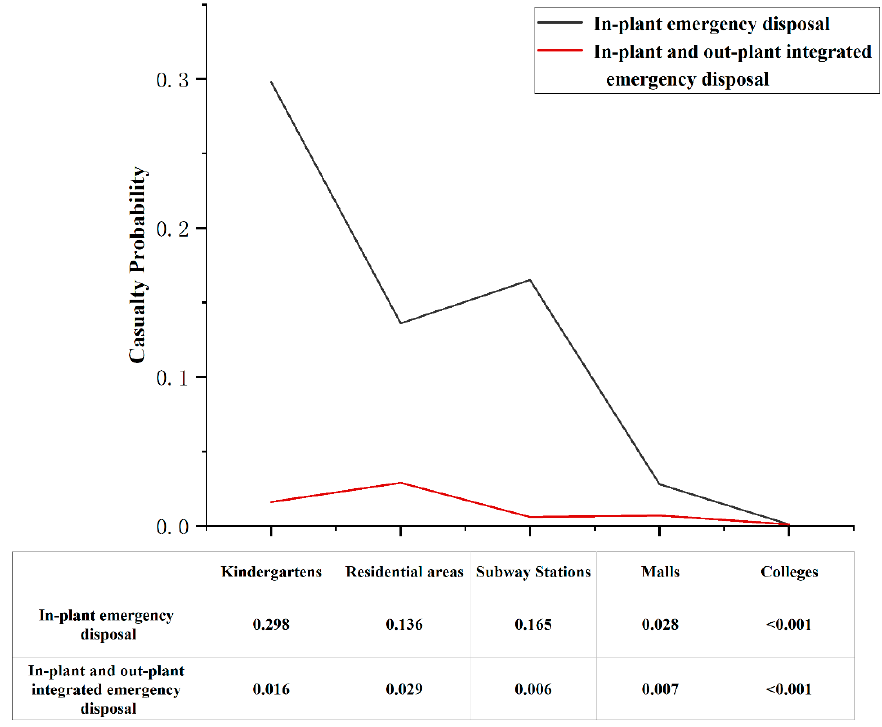
Figure 13. The casualty probability chart under different emergency disposal states (note: probability is 0 to 1).